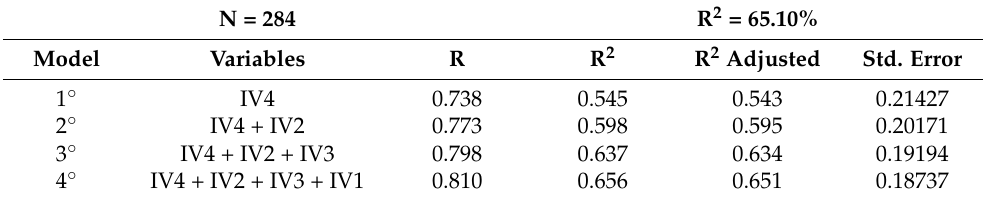
Table 6. RLM predictive model.